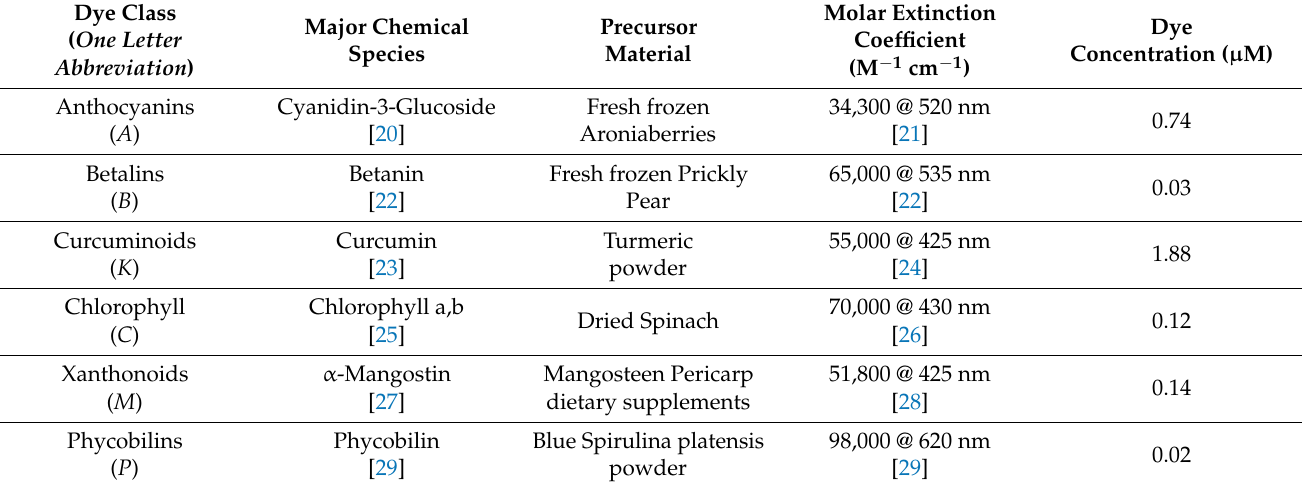
Table 1. Dye classes showing organic precursor materials, major chemical species and the measured concentration of dye extracts via the Beer–Lambert relation. The molar extinction coefficients of the major chemical species were selected from the literature as a proxy for the larger dye